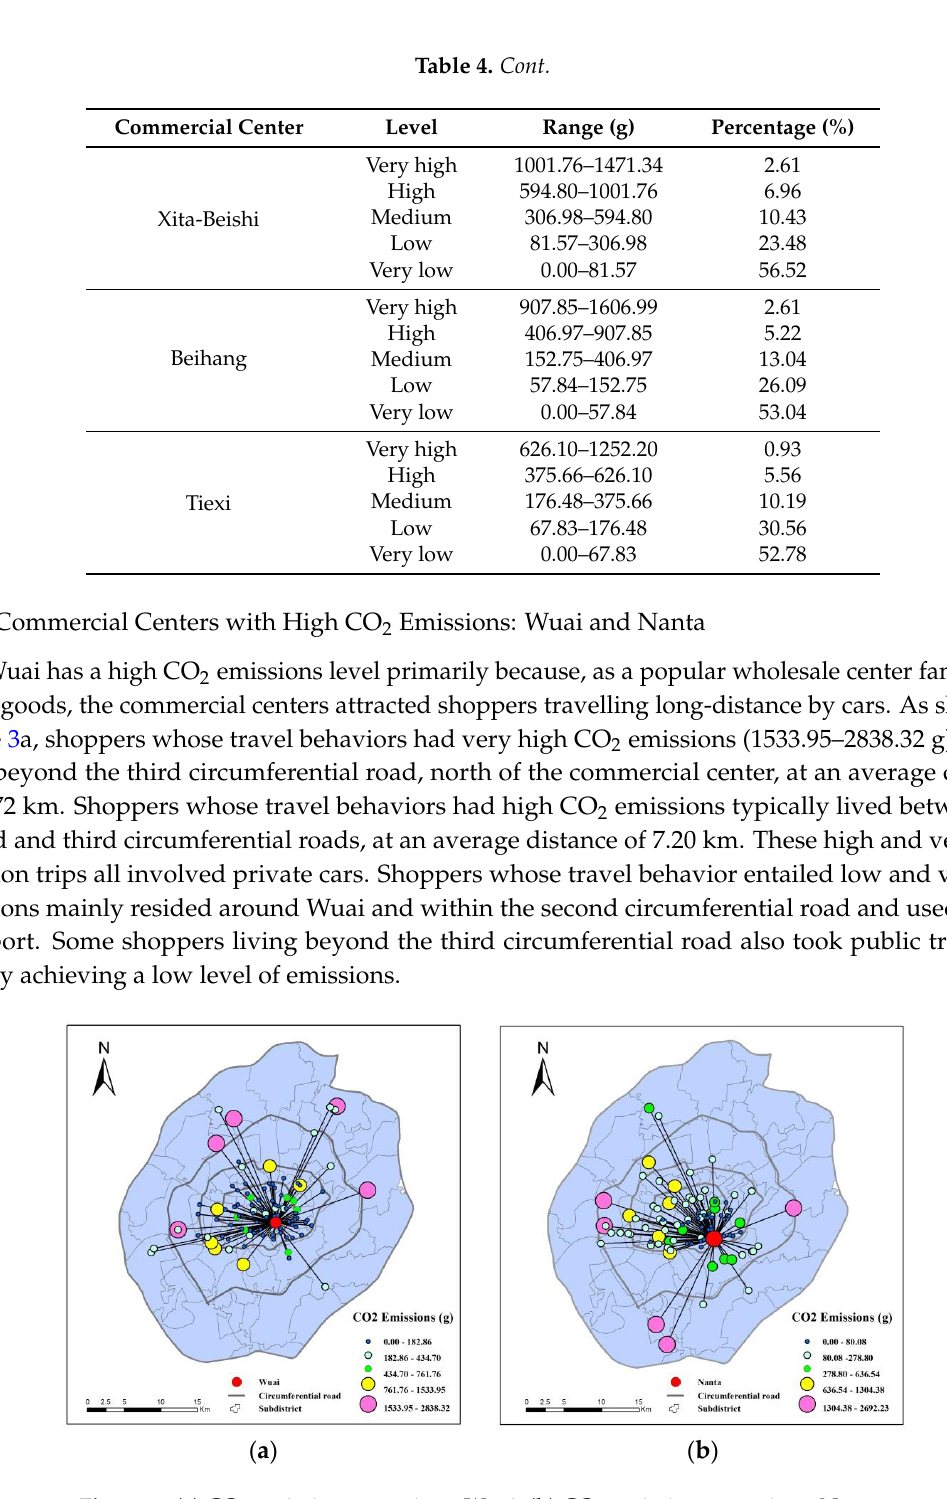
Figure 3. ( a ) CO 2 emissions per trip to Wuai; ( b ) CO 2 emissions per trip to